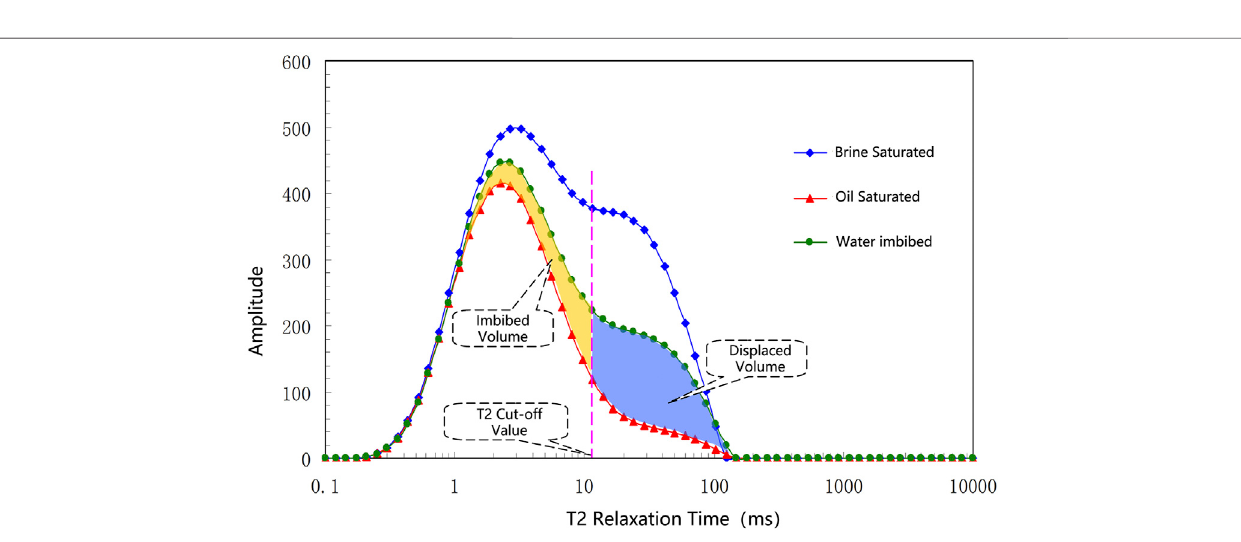
FIGURE 3 | NMR map of movable fl uid imbibition and displacement within typical